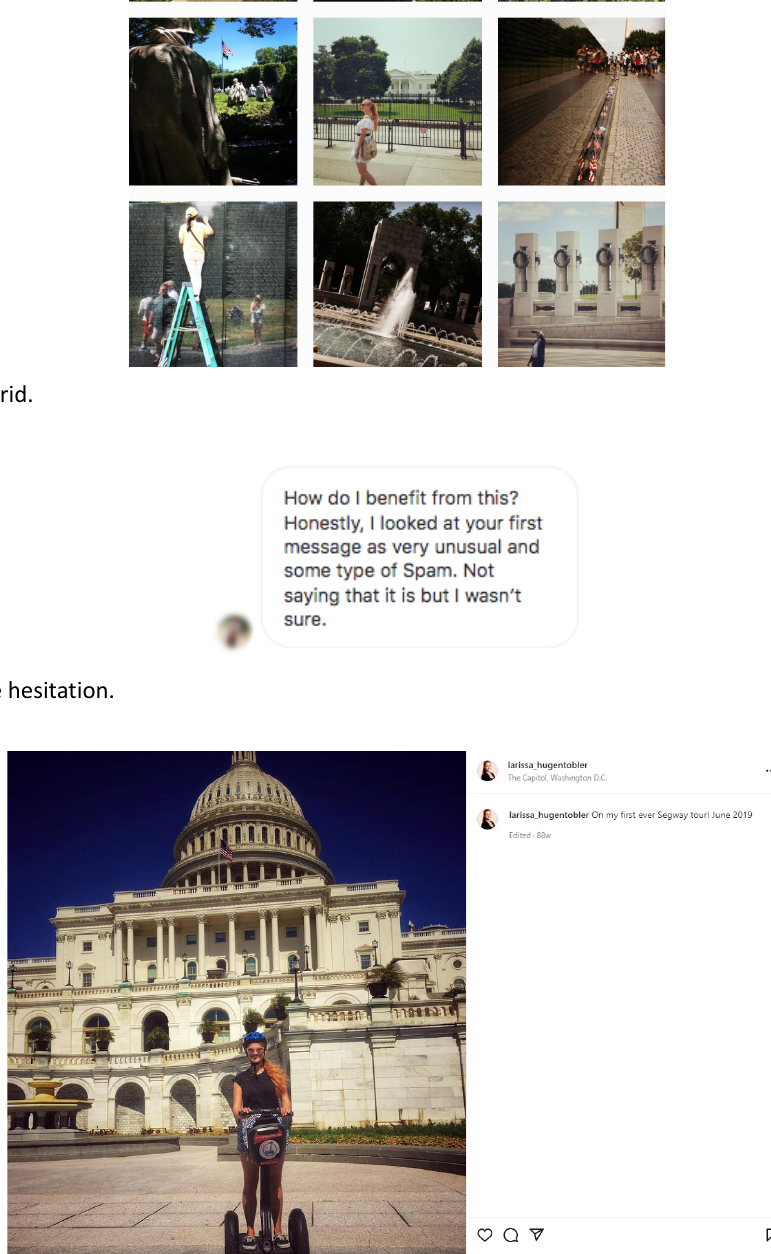
Figure 4. Including the researcher in the